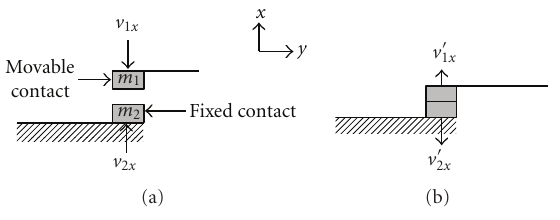
Figure 5: The sketch of movable contact and fixed contact (a) before collision (b) after